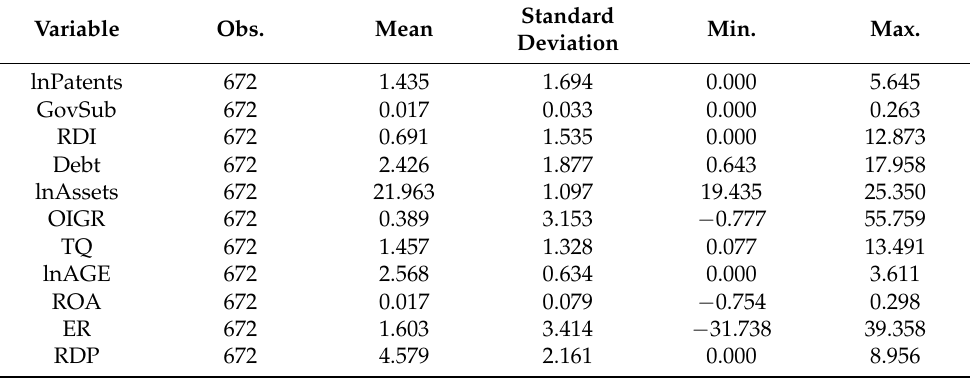
Table 2. Descriptive statistics